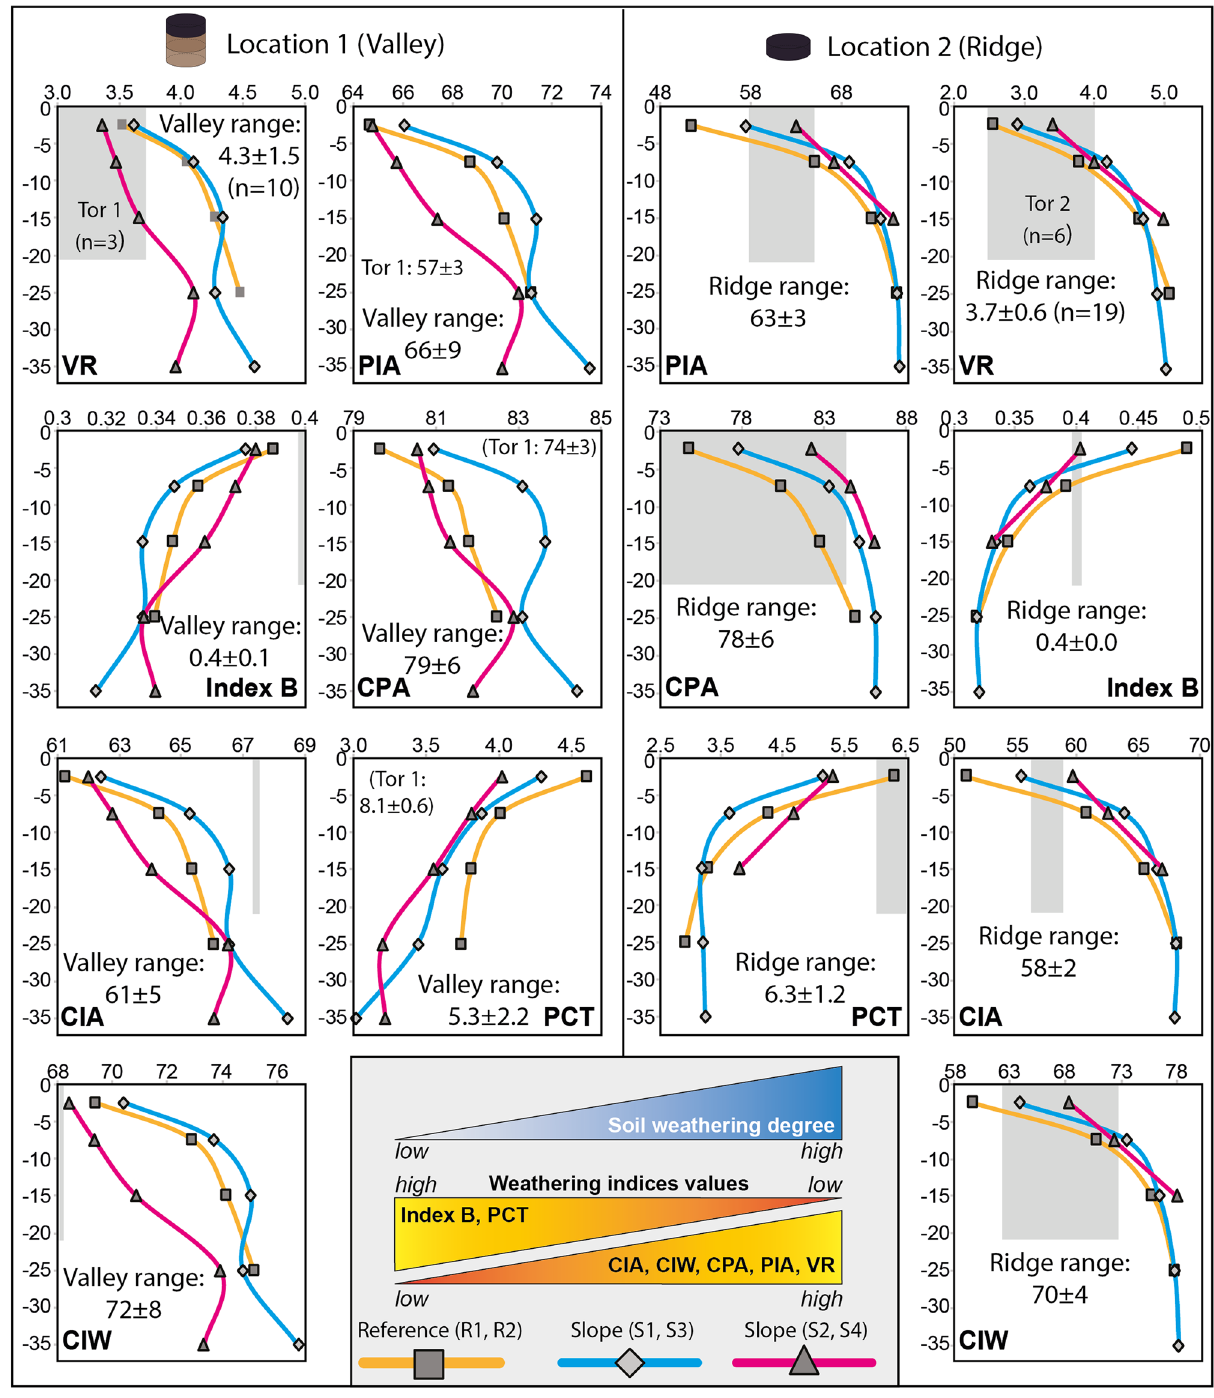
Figure 4. Weathering indices along the soil profiles at reference and slope sites of the two landscape settings (valley, ridge). The y-axis represents the soil depth (in cm) and the x-axis the corresponding average (n = 4) element ratio (see 3.5; Supplementary Table S3). The grey shaded area indicates the range of Tor 1 at the valley (n = 3) and Tor 2 at the ridge (n = 6). In addition, the characteristic range of a larger sample set is provided for the valley (n = 10) and the ridge (n = 19). The coloured triangles in the scheme represent the theoretical relation of soil weathering degree to the various calculated weathering indices: Index B 82 and PCT 76,86 decrease while the CIA 83 , CIW 84 , CPA 85 , PIA 40 , and VR 78 values increase with increasing degree of weathering (see Supplementary Table S4 and “Major and trace element contents and chemical weathering indices” for indices